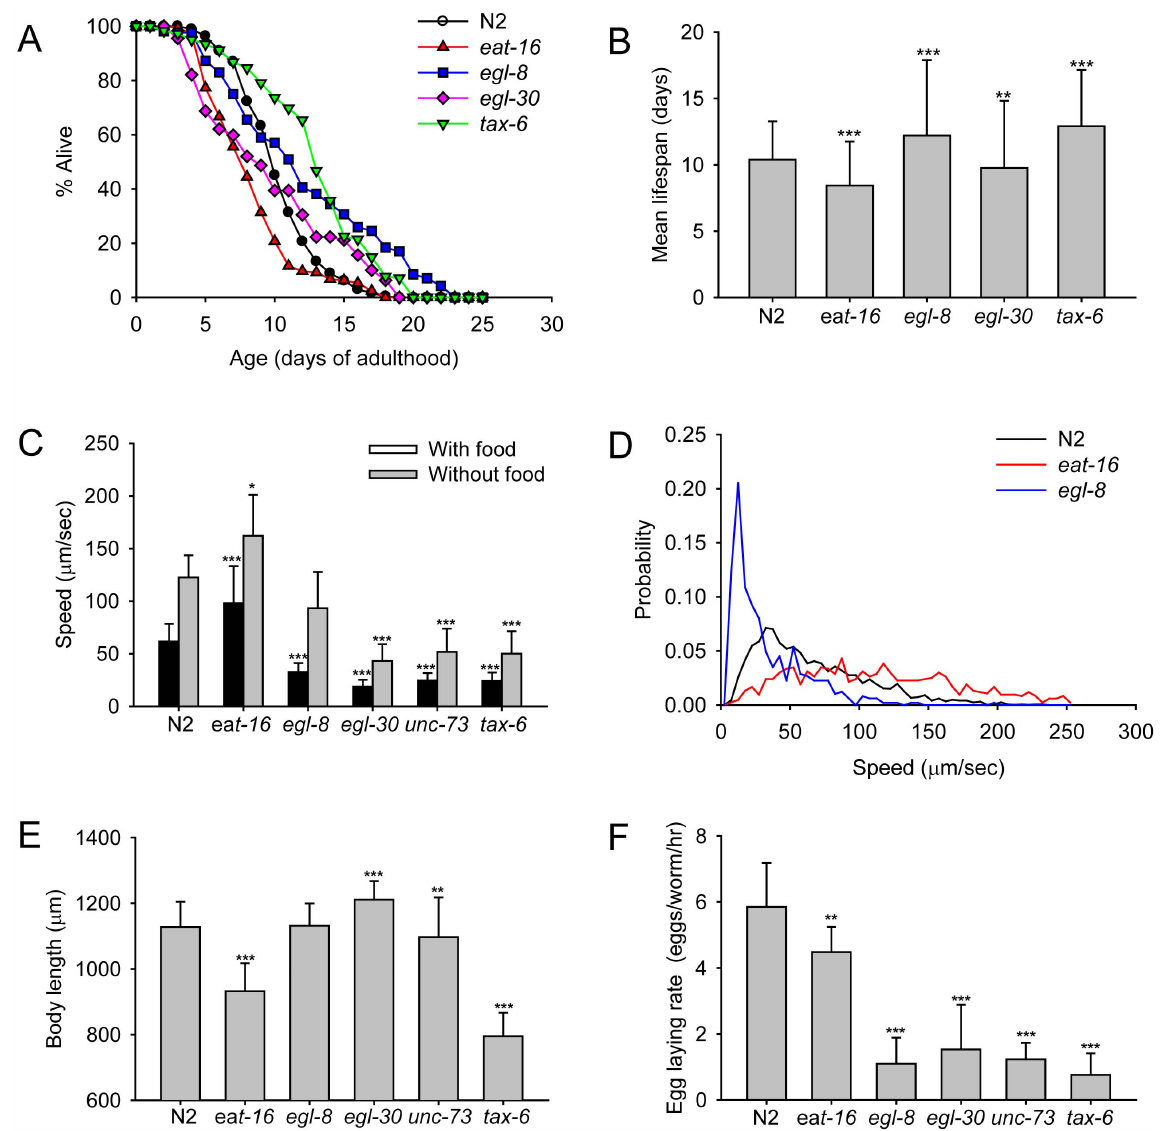
Figure 5. Phenotypes of G a q pathway mutants. (A) Survival curves. The results are from two independent experiments. At least triplicate wells were used ( n . 180 worms for each strain). (B) Mean lifespan. (C) Worm speed measured as the sum of average worm velocities in individual videos divided by the number of videos. With food: For each strain, videos ( n $ 10 videos) collected from four independent experiments were analyzed. Without food: For each strain, videos ( n $ 5 videos) collected from three independent experiments were analyzed. (D) Distribution of individual average speeds of detected tracks ( n $ 487 tracks for each strain) with food (Day 1 , 3 of adulthood). (E) Body length. Worms at 1 day of adulthood were used ( n $ 113 for each strain). (F). Egg laying rate. Worms at 28 hr of adulthood were used. Shown is a combined result from two independent experiments with , 10 hermaphrodites per well ( n $ 12 wells for each strain). * p , 0.01; ** p , 0.05; *** p , 0.001; p -value by log rank test (Figure B) and t-test (Figure C, E, and